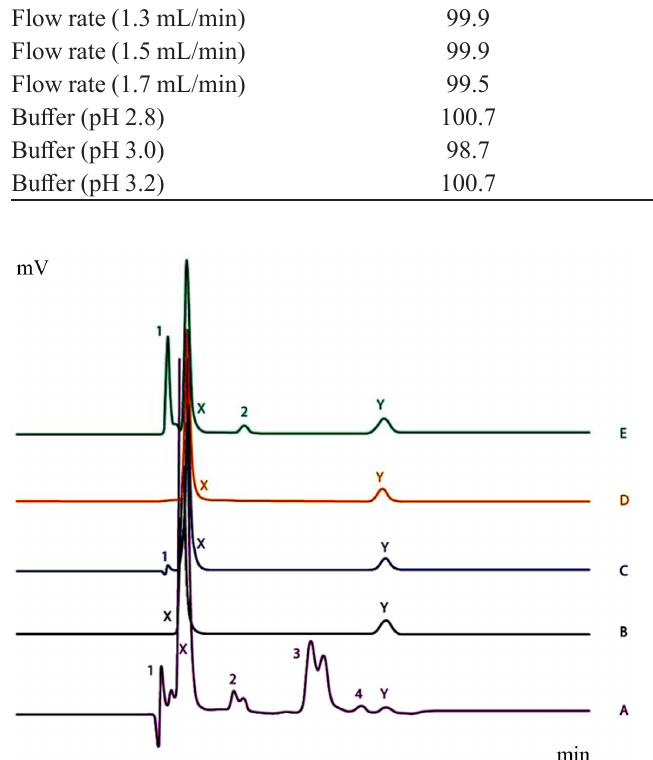
FIGURE 2 - A typical chromatogram of gatifloxacin and dexamethasone under acidic, basic, thermal, photolytic and oxidative stress conditions. Where (X) is gatifloxacin peak, (Y) is dexamethasone peak, (1, 2, 3, and 4) are degradation/ impurities peaks, (A) chromatogram of basic stress, (B) chromatogram of thermal stress, (C) chromatogram of acidic stress, (D) chromatogram of photolytic stress and (E) chromatogram of oxidative